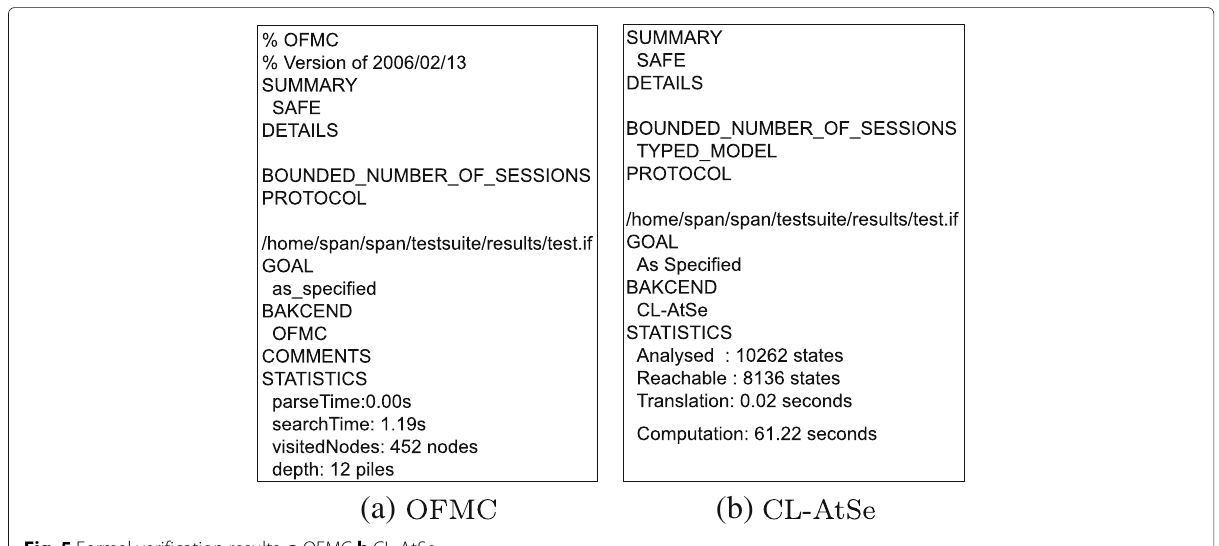
Fig. 5 Formal verification results. a OFMC b CL-AtSe